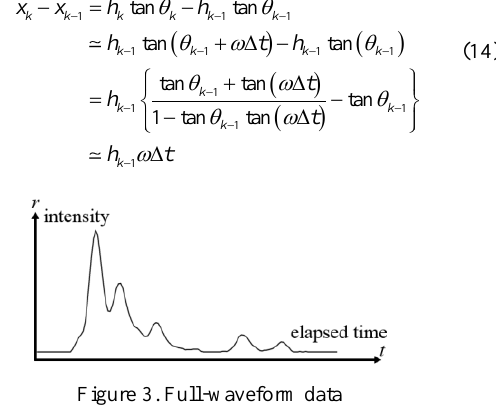
Figure 3. Full-waveform data